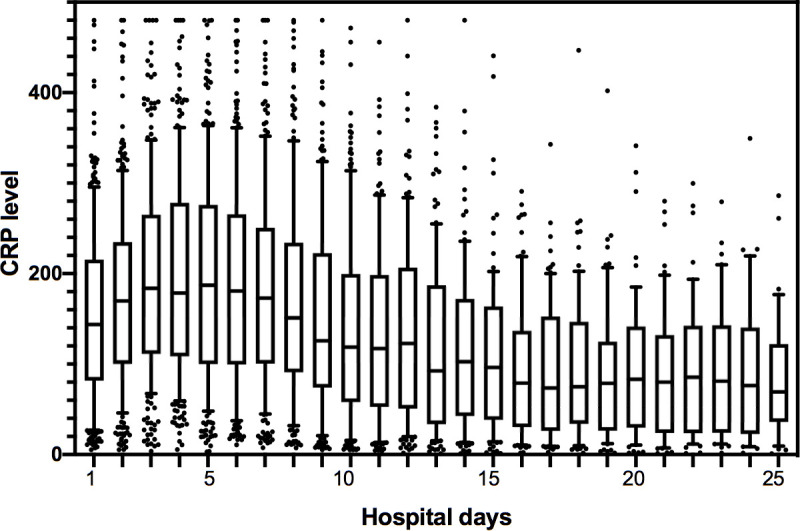
Trends of change in CRP levels in hospitalized COVID-19 patients (n = 268).Box plots represent median CRP (with IQR, 10th and 90th percentile and outliers) for the cohort on each given day, up to day 25 of hospitalization.